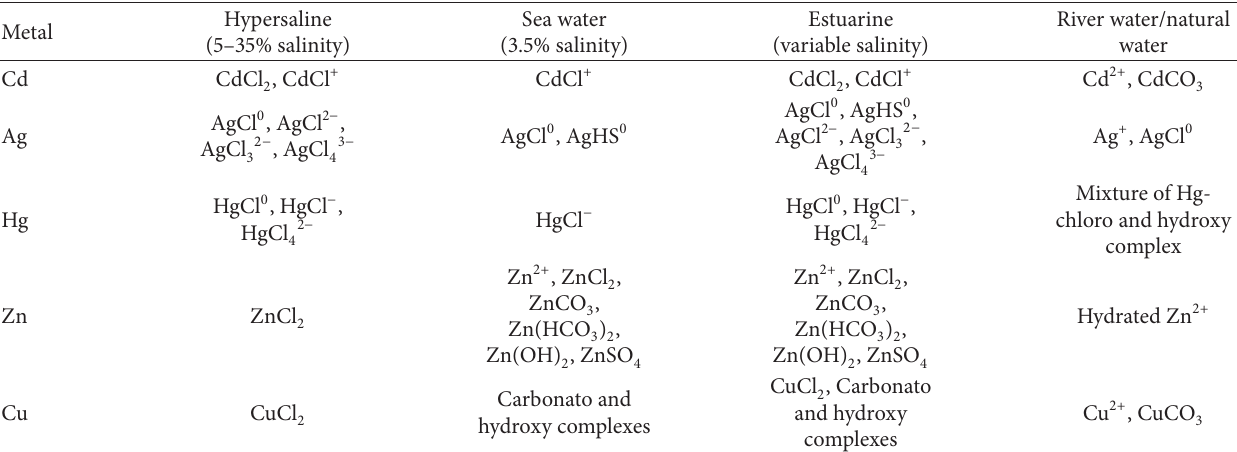
Table 1: Various inorganic complexes formed in natural waters, seawater, estuarine waters (variable salinity), and hypersaline waters. As haloarchaea inhabit hypersaline environments where inorganic ligands predominate, inorganic metal speciation is described. The availability of metal depends upon the kind of inorganic complex formed. Lipophilic soluble chlorocomplexes of Hg and Ag are easily available in and CuCl are unavailable to the organism. Fe (II), Co (II), Ni (II), and Mn (II) form weak hypersaline waters. Insoluble (precipitated) ZnCl 2 2 complexes with Cl − that easily dissociate and can be taken up by organisms [28, 41–46].